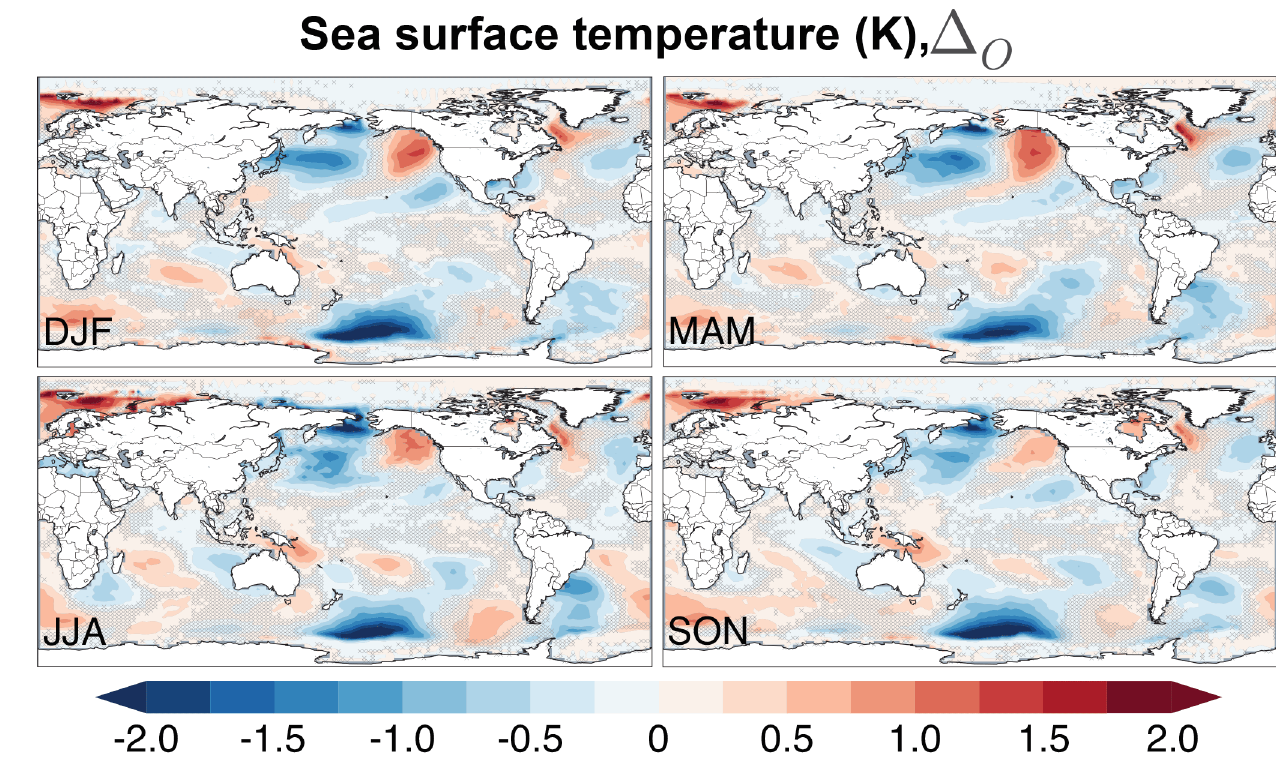
Figure 4. Difference in SST (K) due to irrigation with interactive SST ( (cid:49) O ). Differences not significant at the 0.05 level are hatched